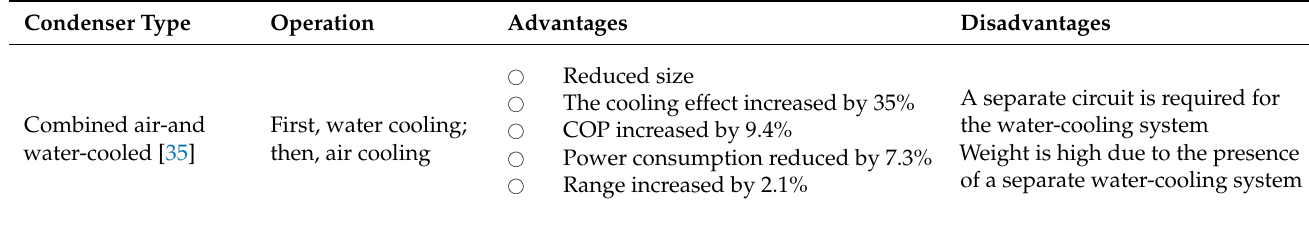
Table 2. Condensers and their advantages and disadvantages.